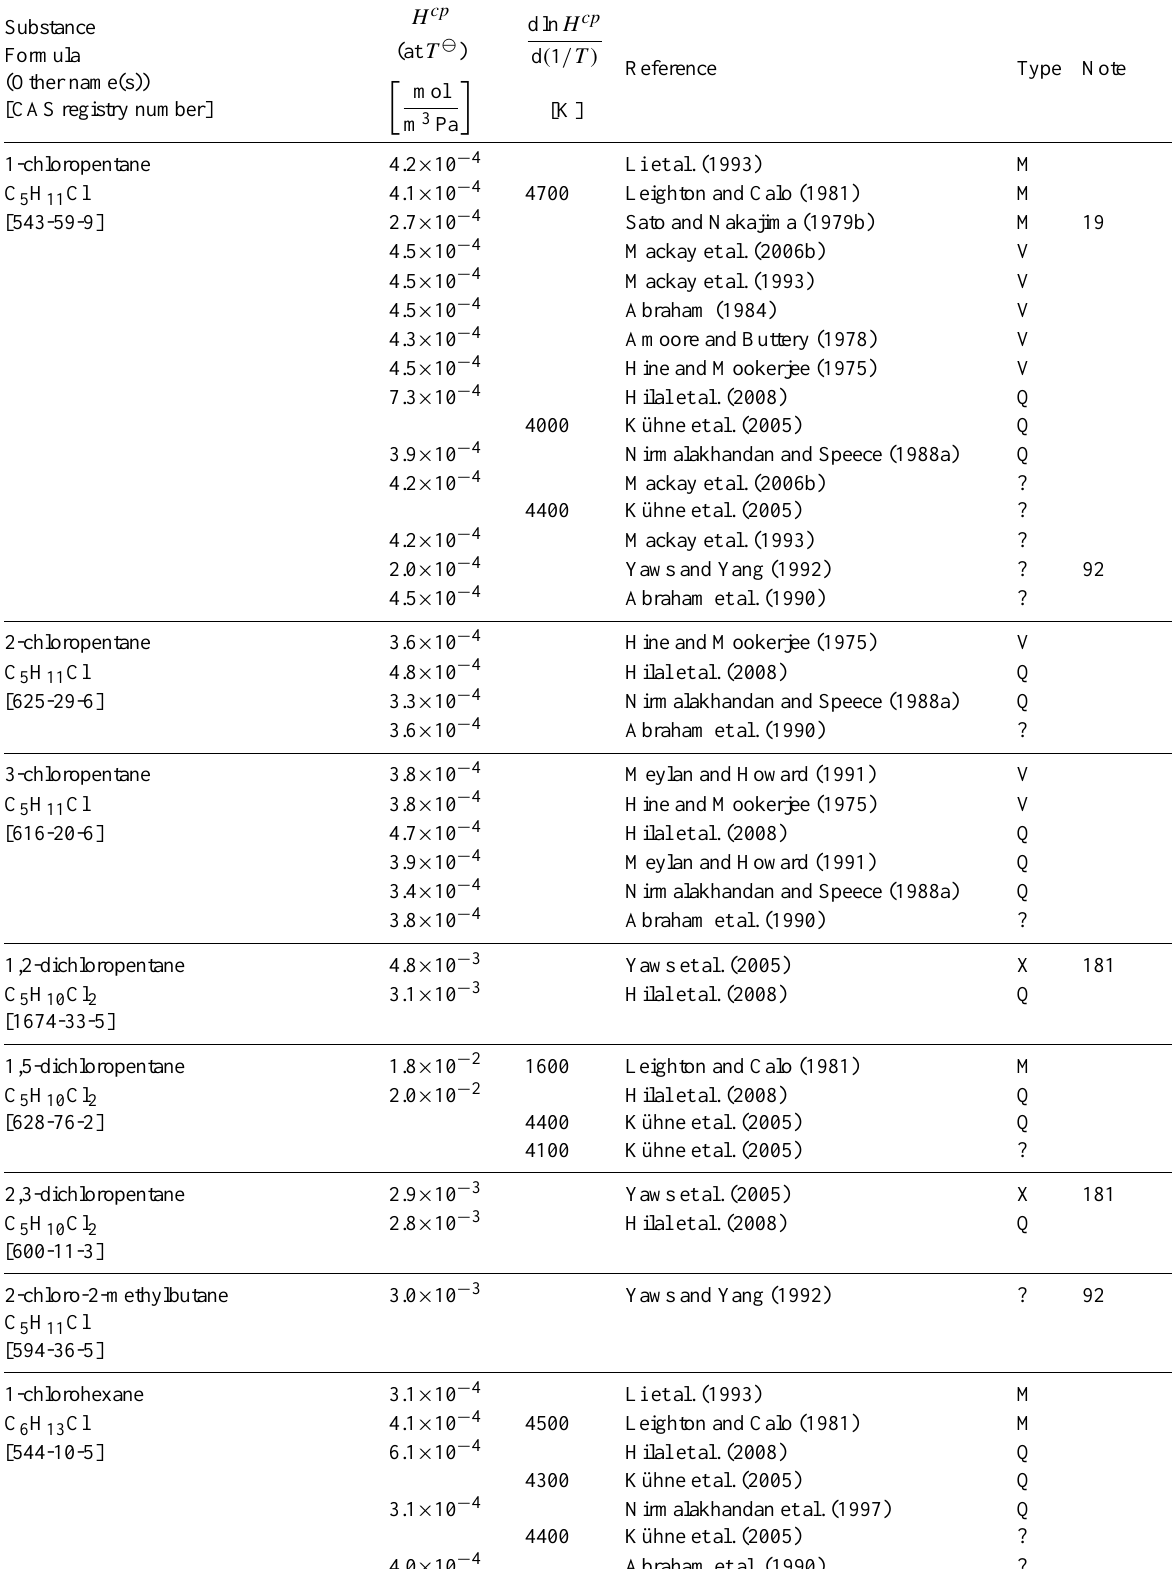
Table 6: Henry’s law constants for water as solvent